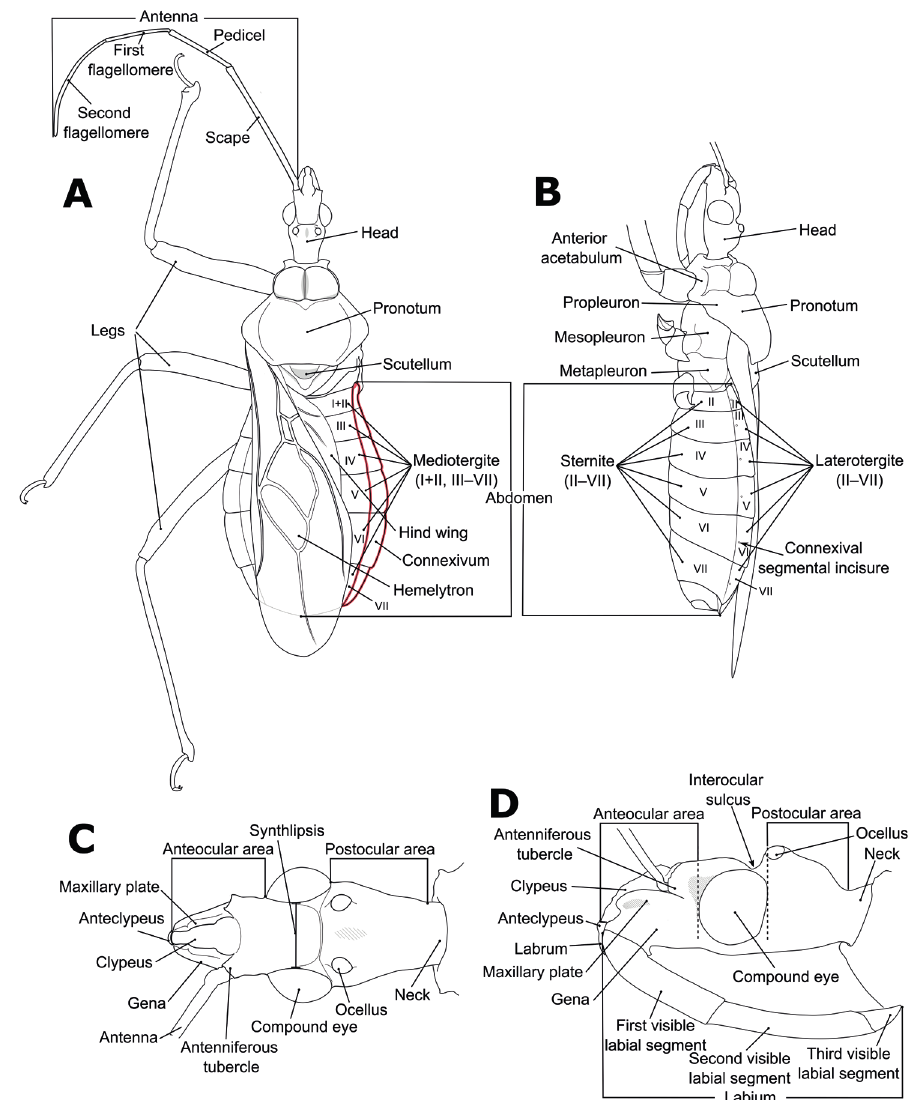
Figure 1. Structure and morphological terms of Biasticus species. Drawing based on Biasticus luteicollis Ha, Truong & Ishikawa, sp. nov., paratype, ♀ , HNL2018-024 A 4 body in dorsal view B body in lateral view C head in dorsal view D head in lateral